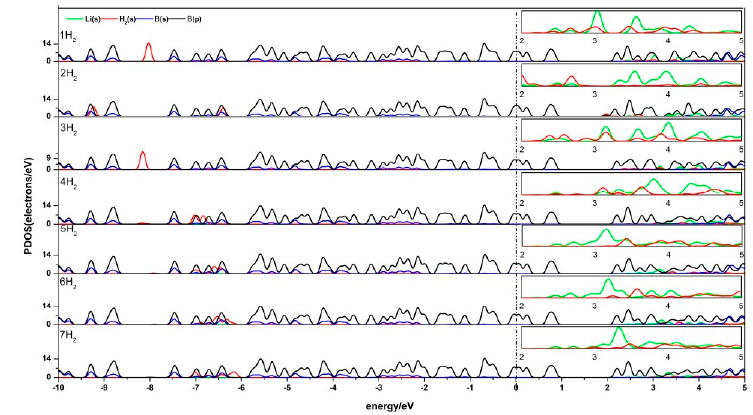
Figure 6. PDOS of Li- β 12 -borophene with 1–7 H 2 molecules adsorbing. (The PDOS of Li-s orbit and H-s orbit in the range of 2.0 eV~5.0 eV is enlarged as shown in the small box above each corresponding